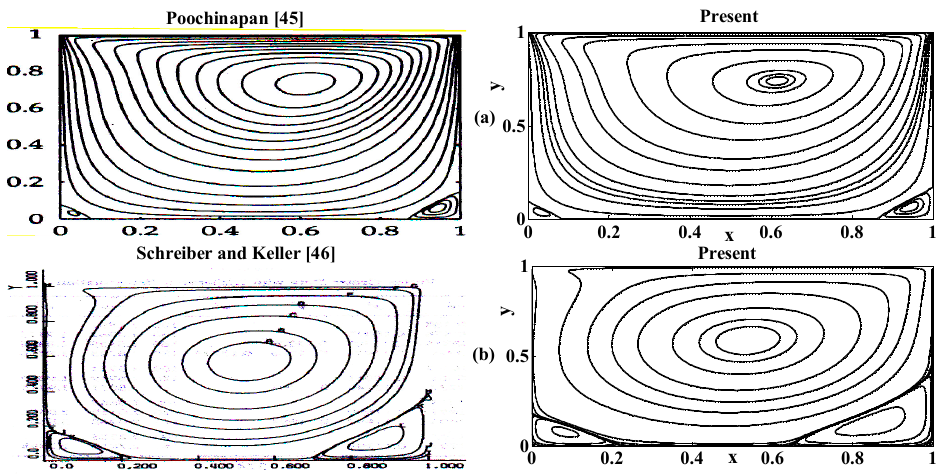
(cid:110) (cid:111) = S t , α p , γ